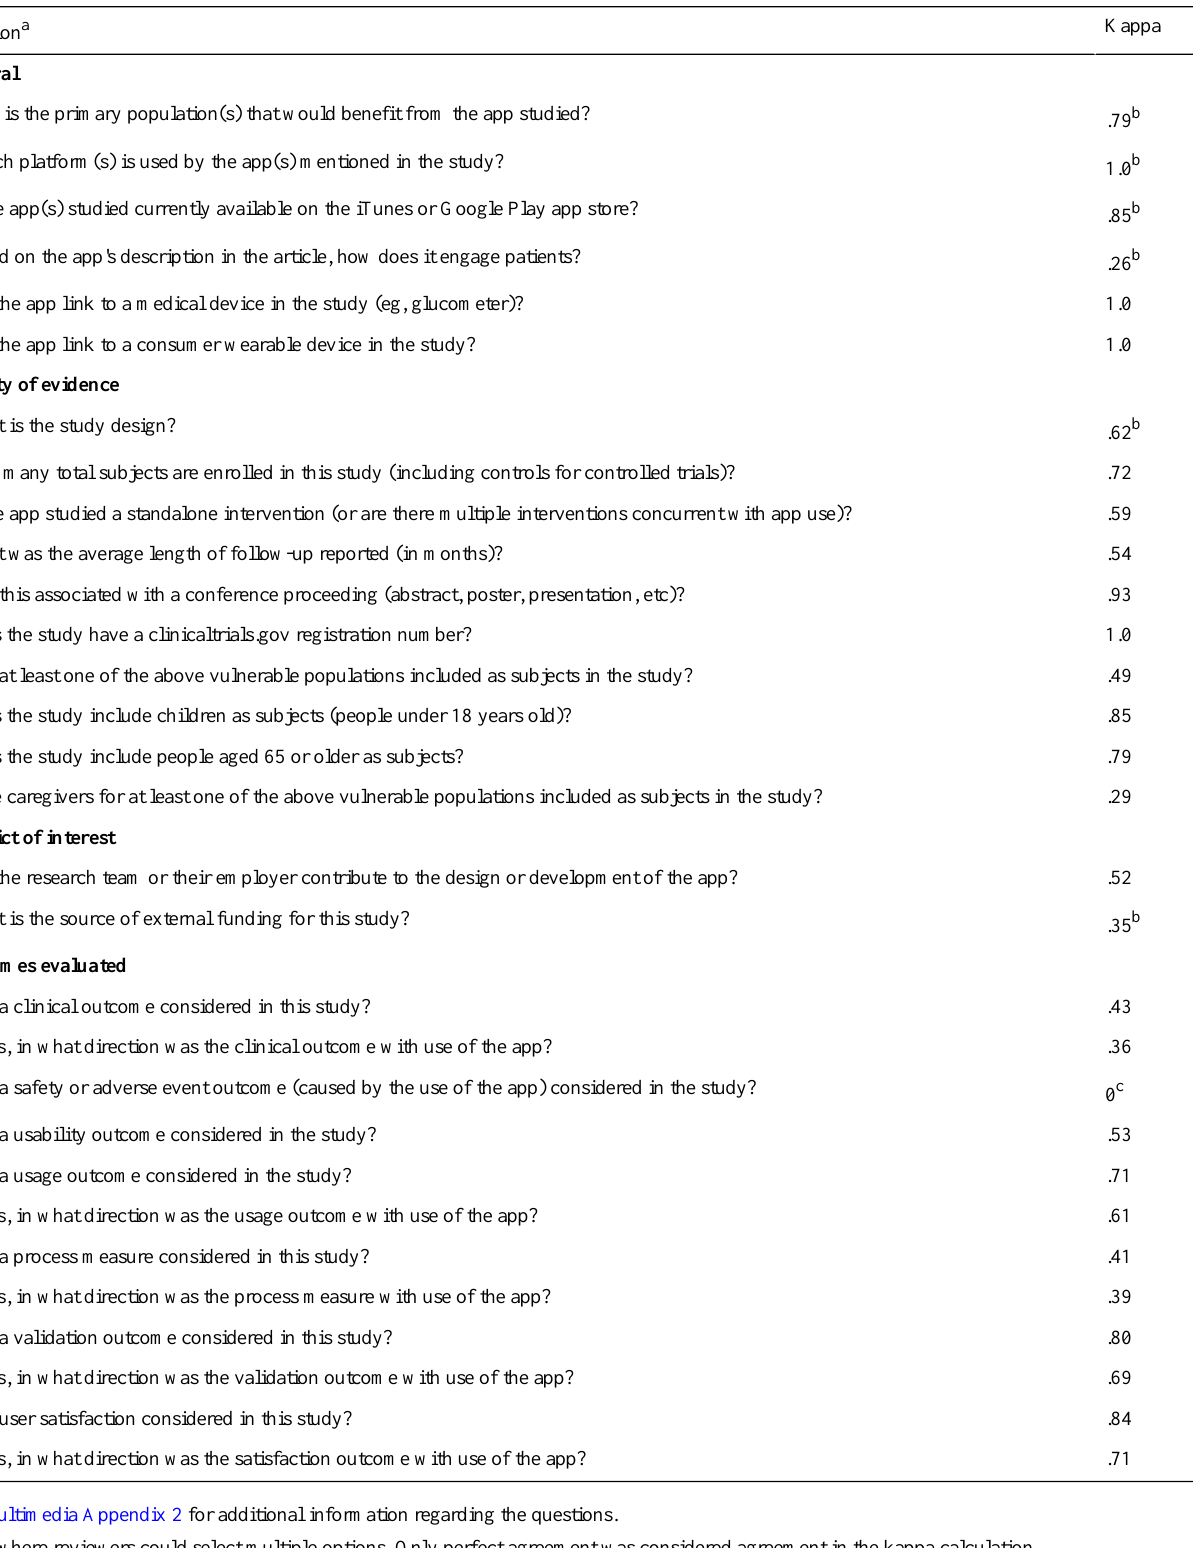
Table 1. Level of agreement on items on the abstraction